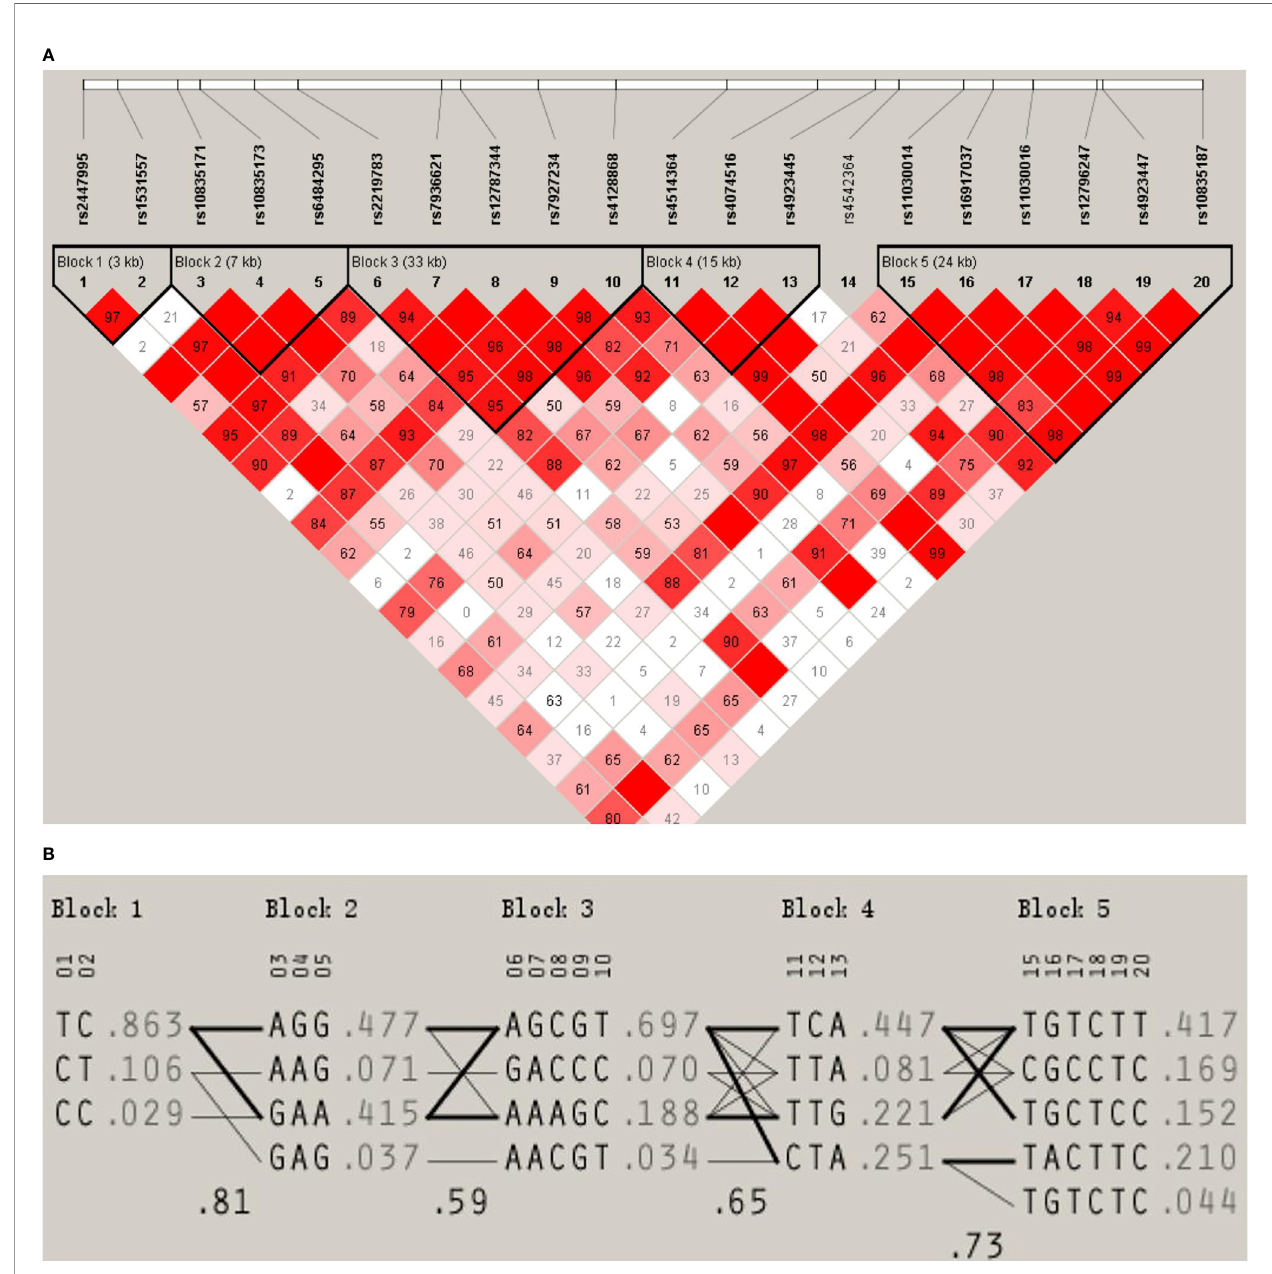
FIGURE 1 | (A) LD pattern for the LGR4 gene. The LD block structure is described by Haploview. From white to red, the increase in color indicates an increase in the strength of the LD. The values in the cells are the pairwise degrees of the LD. (B) Haplotype frequencies of the LGR4